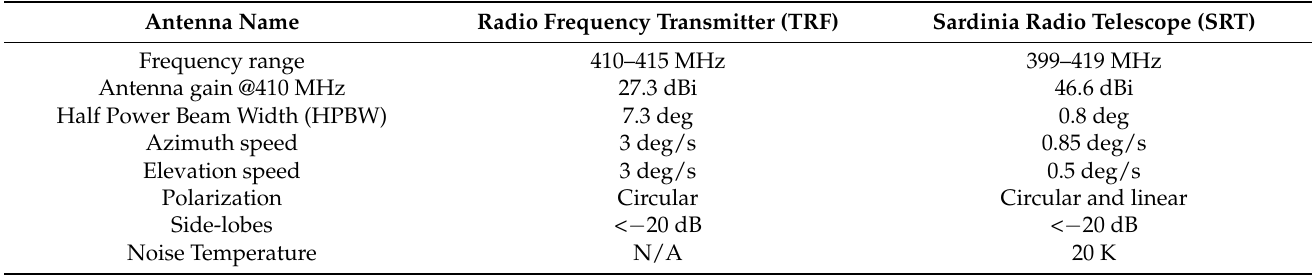
Table 1. Main features of the Bi-Static Radar for LEO Tracking (BIRALET) radar.